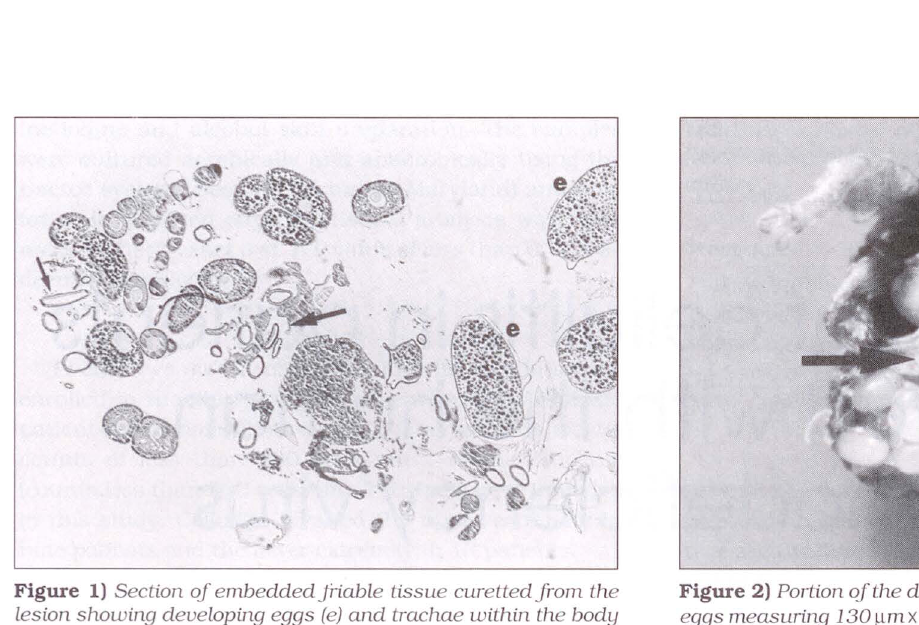
Figure 2) Portion of the debrided tissue showing the white. oval eggs measuring 130 ~Lm X 65 ~~ m and the head of thejlea (arrow). x19 Chigoe fleas commonly burrow between the toes. under the toe nails or the sole of the foot, although they may attack any exposed area of the body. The symp toms of tungiasis are mainly pain or intense pruritus of the affected area, resulting in continuous scratching. The flea initially appears as a minute black spot in the skin, but as it enlarges, an erythematous papule devel ops. This itches and becomes painful; fleas beneath the nails are especially